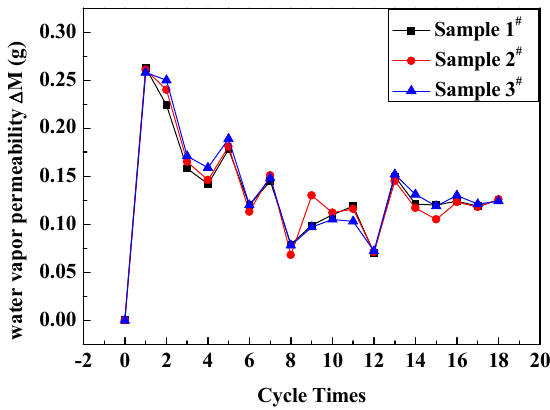
Figure 4. Water vapor permeability results.